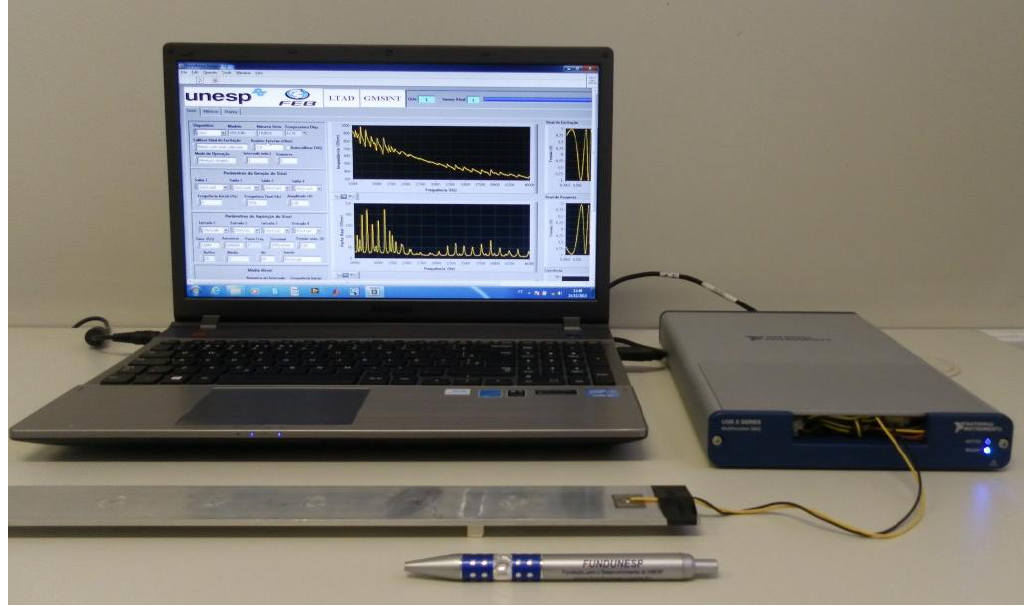
Figure 4. Experimental